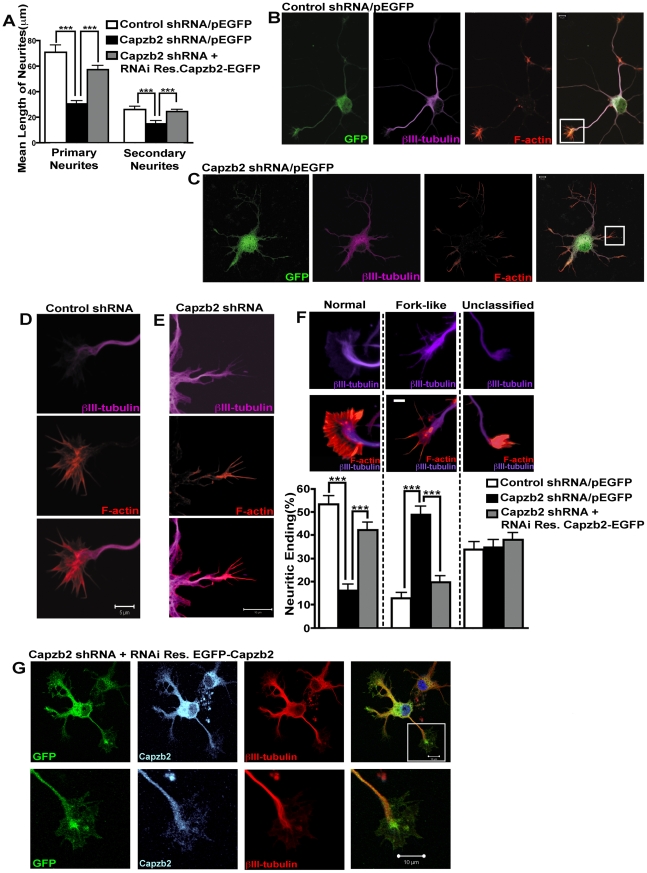
Capzb2 RNAi causes shorter neurites and alters morphology of growth cones/actin-rich neuritic endings in hippocampal neurons.(A) Mean length of primary and secondary neurites of neurons transfected with control shRNA/pEGFP, Capzb2 shRNA/pEGFP, or Capzb2 shRNA/RNAi resistant (Res) Capzb2-EGFP (ratio 4∶1) were analyzed 72 h posttransfection and 4% paraformaldehyde fixation. Capzb2 shRNA transfection results in reduced length of both primary and secondary neurites; concomitant transfection of RNAi Res Capzb2-EGFP reverses the effect of Capzb2 RNAi. Mean values ±s.e.m. (n = 100 neurons in each category) are depicted; *** = p<0.001. (B and C) Representative shRNA/pEGFP transfected neurons: (B) control shRNA/pEGFP and (C) Capzb2 shRNA/pEGFP; GFP (green), F-actin (red), and βIII-tubulin (purple); scale bar indicates 10 µm. (D) Higher magnification of a normal growth cone delineated by the white box in (B), characterized by an F-actin–rich periphery (red) and a βIII-tubulin–rich C-zone (purple); scale bar indicates 5 µm. (E) Higher magnification of a growth cone delineated by the white box in (C) in which there is overlap of F-actin (red) and βIII-tubulin (purple) signal; scale bar indicates 5 µm. Note the altered morphology as characterized by the absence of lamellipodia, resulting in a fork-like appearance. (F) Representative images of βIII-tubulin (purple) and F-actin (red) in normal, fork-like, and unclassified growth cones/actin-rich neuritic endings (scale bar indicates 5 µm), and quantification of each of these categories in neurons transfected with control shRNA/pEGFP, Capzb2 shRNA/pEGFP, and Capzb2 shRNA+RNAi Res Capzb2-EGFP (rescue transfection). The neurons were fixed in PHEM buffer 48 h posttransfection. The neuritic ending morphology classified as fork-like lacked lamellipodia, and the βIII-tubulin signal (purple) extended into the periphery and overlapped with F-actin (red) rather than being confined centrally as in normal growth cones. Fork-like “growth cones” dominated in neurons transfected with Capzb2 shRNA, whereas normal growth cones were significantly more common in control and rescue conditions. The third category, unclassified, represents neuritic endings that could not be classified as either normal or fork-like. These neuritic endings had uniform appearance and were found in similar frequencies across the experimental conditions. more than 230 growth cones/actin-rich neuritic endings from neurons belonging to each category were analyzed; mean values ±s.e.m. are depicted; *** = p<0.001. (G) EGFP-Capzb2 is present in the neuronal soma and processes including the growth cones where it colocalizes with βIII-tubulin. The lower panels are higher magnifications of the area delineated by the white box in the upper right-hand panel.